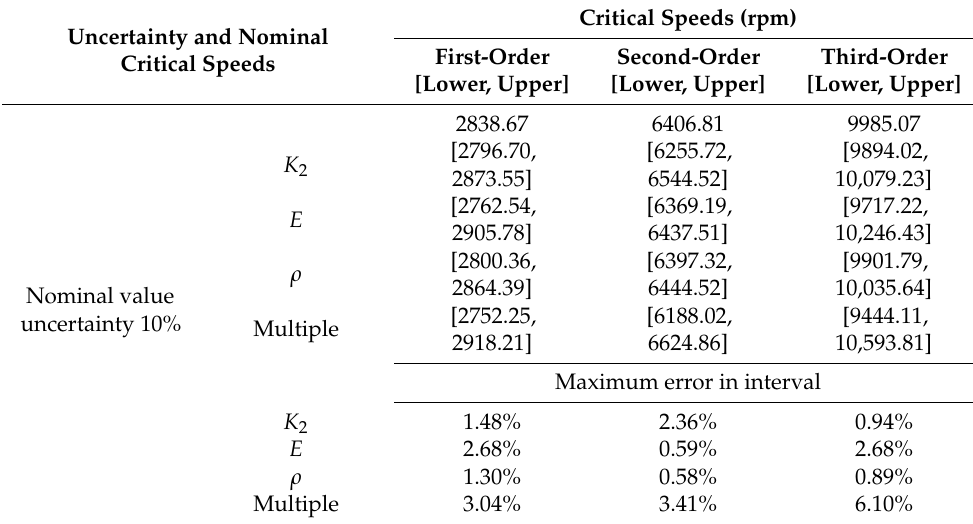
Table 5. Calculation of critical speeds under different uncertainty parameters.